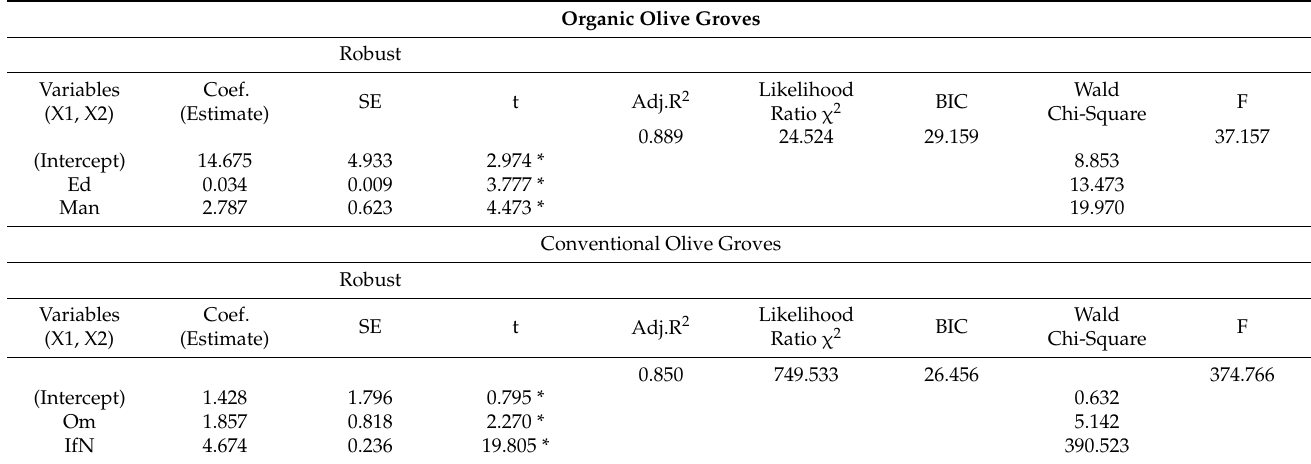
Table 3. Factors influencing yield (Y variable) in organic and conventional olive groves. Organic Olive Groves